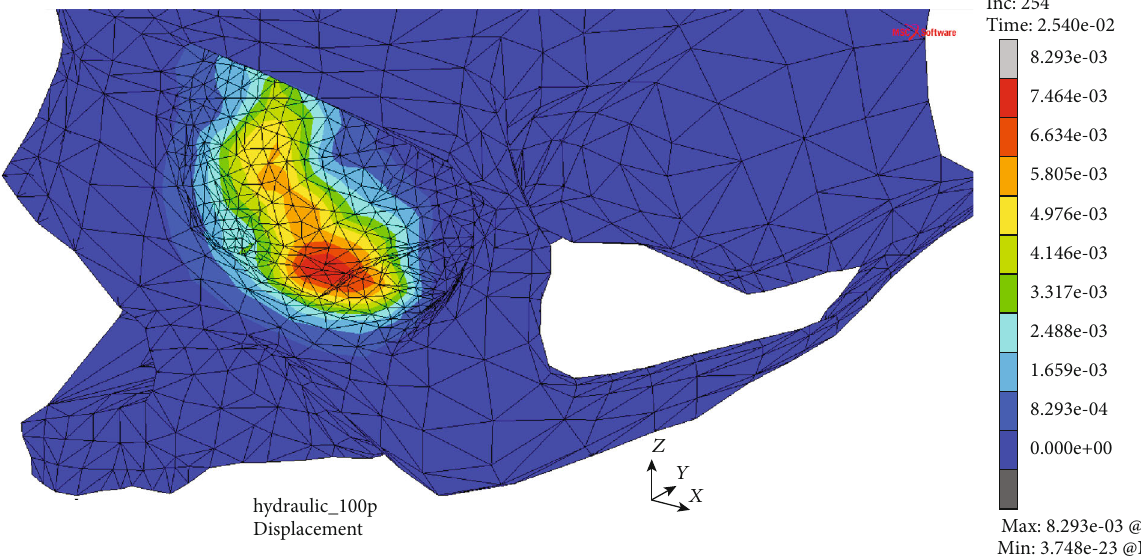
Figure 5: Displacement map (mm) without the deformation within the analyzed thin shell skull part during time t = 25 : 4ms (MOBOSE).